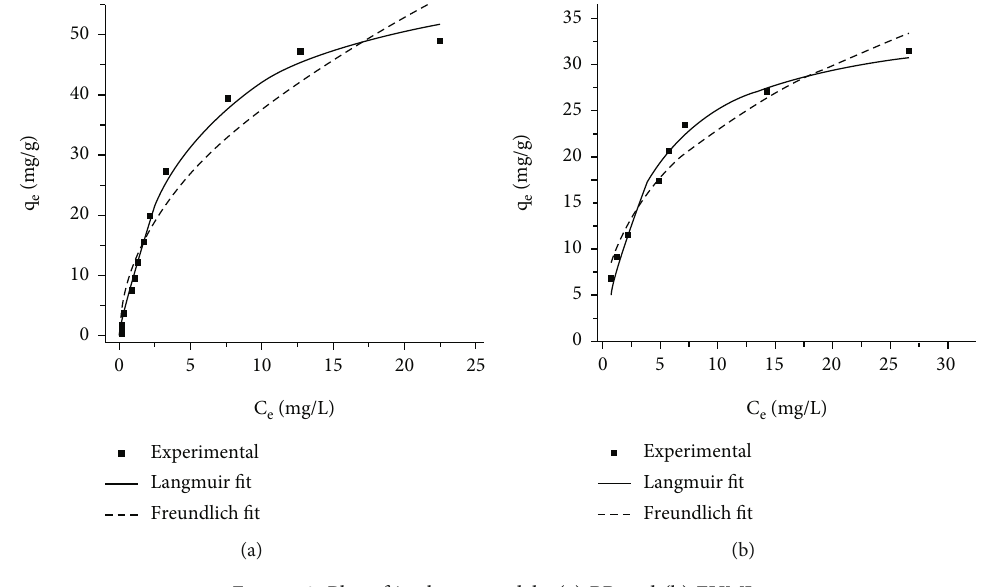
Figure 9: Plot of isotherm models: (a) BB and (b)